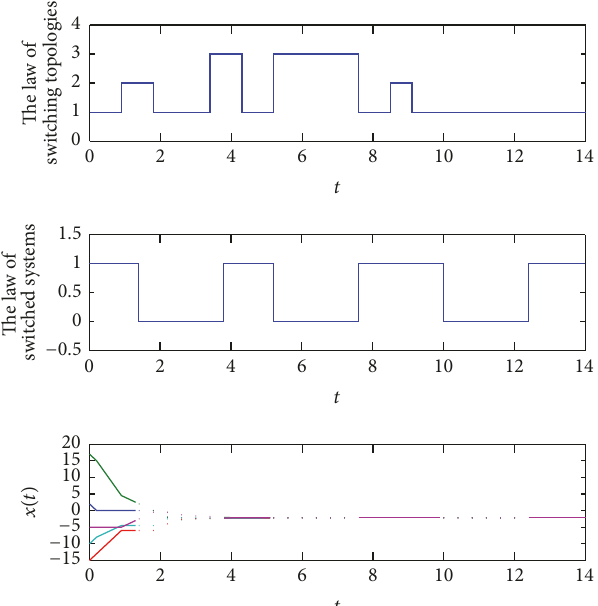
Figure 3: Consensus of switched systems on undirected graph with switching